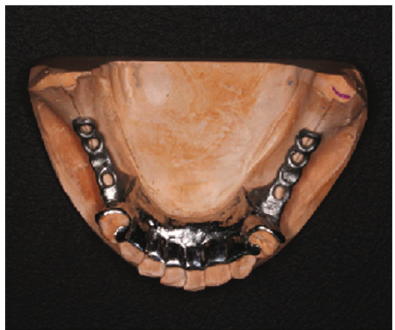
Figure 17: Chrome cobalt